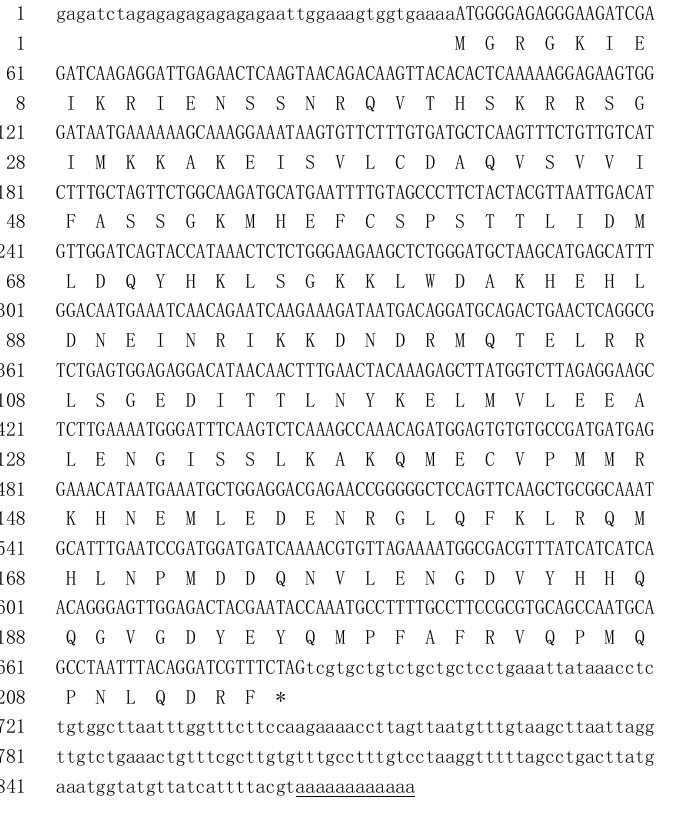
Figure 1. cDNA sequence of OfGLO1 and its deduced amino acid sequence. Note: * means a stop codon. The underlined sequence is the typical tail signal poly (A). The sequence information for OfGLO1 has been submitted to the GenBank database. The accession number is KY575409. 3.2. Sequence Alignment and Phylogenetic Analysis of GLO Homologs Among Different Species The amino acid sequence alignment of OfGLO1 with other species of homologous proteins showed that the MADS MEF2-like and K-box, typical features of the MADS-box type II gene, were highly conserved. The MADS MEF2-like structure and the K-box struc- ture in OfGLO1 are located at amino acids 2-80 and at amino acids 83-163, respectively (Figure 2a). In addition, a 16-amino-acid PI motif (MPFAFRVQPMQPNLQE) was found in the C terminal region, indicating that OfGLO1 is a PI/GLO-type member of the class B MADS-box gene. The homology search showed that OfGLO1 had the highest similarity to JmGLO1 from Jasminum mesnyi, with a homology of 91%, followed by 83% with BdGLO1 in Buddleja davidii and 81% with LcGLO1 in Lantana. Other GLO proteins from sesame, Verbena , monkey flower, and snapdragon had 86%, 85%, 85%, and 82% homolo- gies, respectively, with OfGLO1.